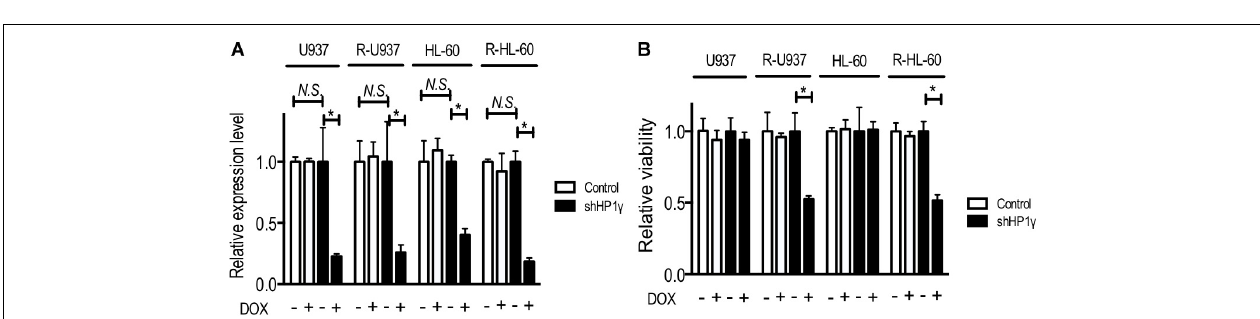
FIGURE 1 | (A) The protein expression of HP1 family members after AZA treatment at 5 µ M for 72 h in U937, R-U937, HL-60, and R-HL-60 cells. Typical blots from a representative experiment are shown. The experiments were repeated three times. (B–D) Relative mRNA expression of HP1 α (B) , β (C) , and γ (D) after incubation with ( + ) or without (–) 5 µ M AZA for 72 h in U937, R-U937, HL-60, and R-HL-60 cells. The expression level was normalized with ACTB mRNA expression. The means ± SD from three independent experiments are shown. P -values < 0.05 were indicated.